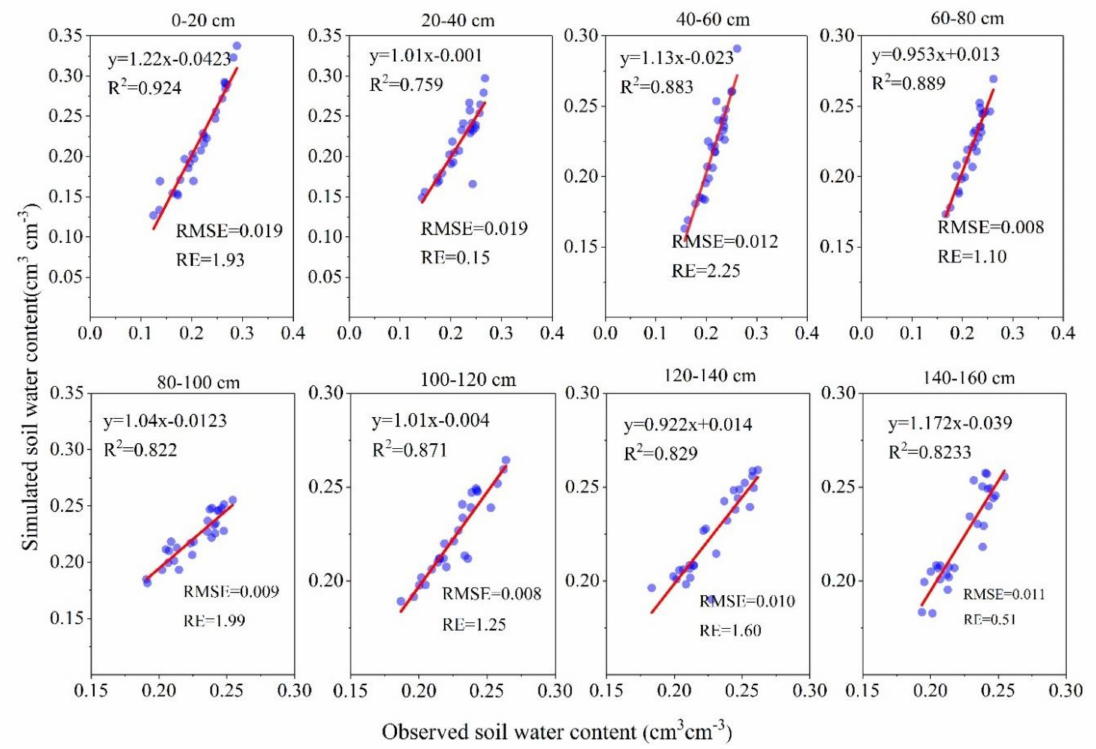
Figure 4. The linear relationship between the experimental and simulated values of soil water content at different soil depths. The root mean square error (RMSE), relative error (RE), and coefficient of determination (R 2 ) are shown.